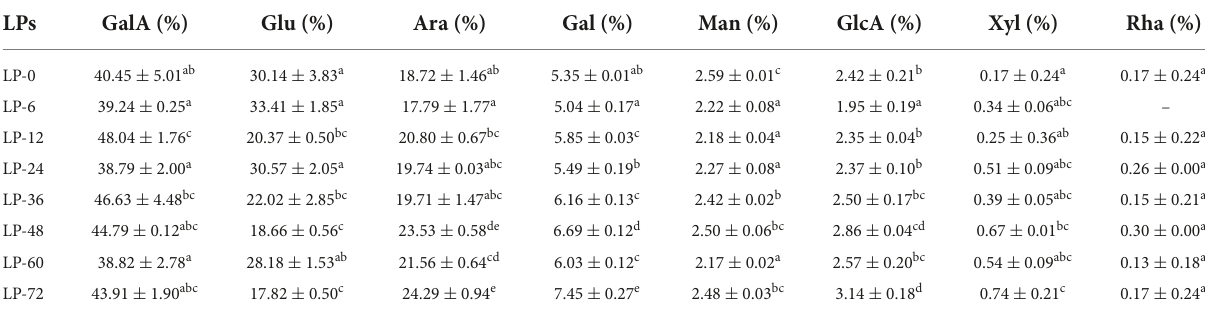
TABLE 2 Monosaccharide compositions of polysaccharides derived from litchi pulp fermented with Lactobacillus fermentum for different times.